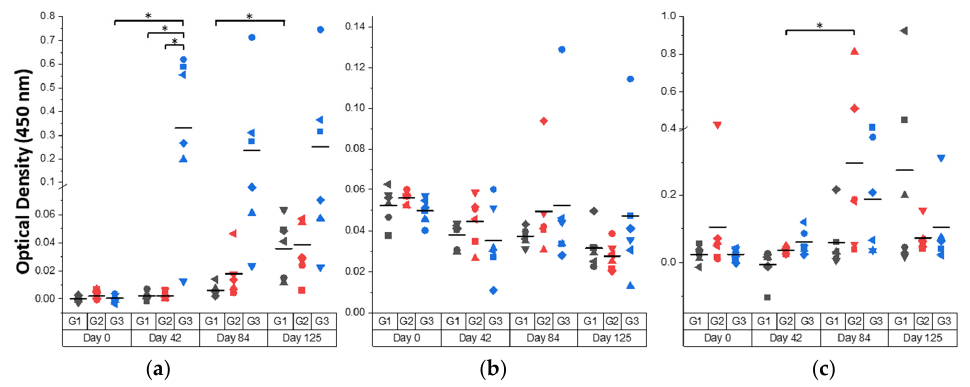
Figure 6. Bovine humoral response towards rFhTSP2 over the course of the trial. ( a ) Serum IgG, ( b ) serum IgA, and ( c ) saliva IgA responses from Day 0 (pre-vaccination), Day 42 (post-vaccination), Day 84 (post-challenge), and Day 125 (end of trial) from Group 1 (G1: dark grey) subcutaneously vaccinated with PBS; Group 2 (G2: red) intranasally vaccinated with rLTB-FhTSP2; and Group 3 (G3: blue) subcutaneously vaccinated with rFhTSP2. Each animal within a group is represented by a different shape. The reactivity of 5 µ g/mL of rFhTSP2 was analysed using serum (diluted 1:50) or saliva (diluted 1:8) and an anti-bovine IgG HRP secondary antibody diluted 1:5000 or a anti-bovine IgA HRP antibody diluted 1:2000. The mean OD of each group is represented by a solid line. Significant differences ( p < 0.05) of the mean are denoted by asterisks (*).